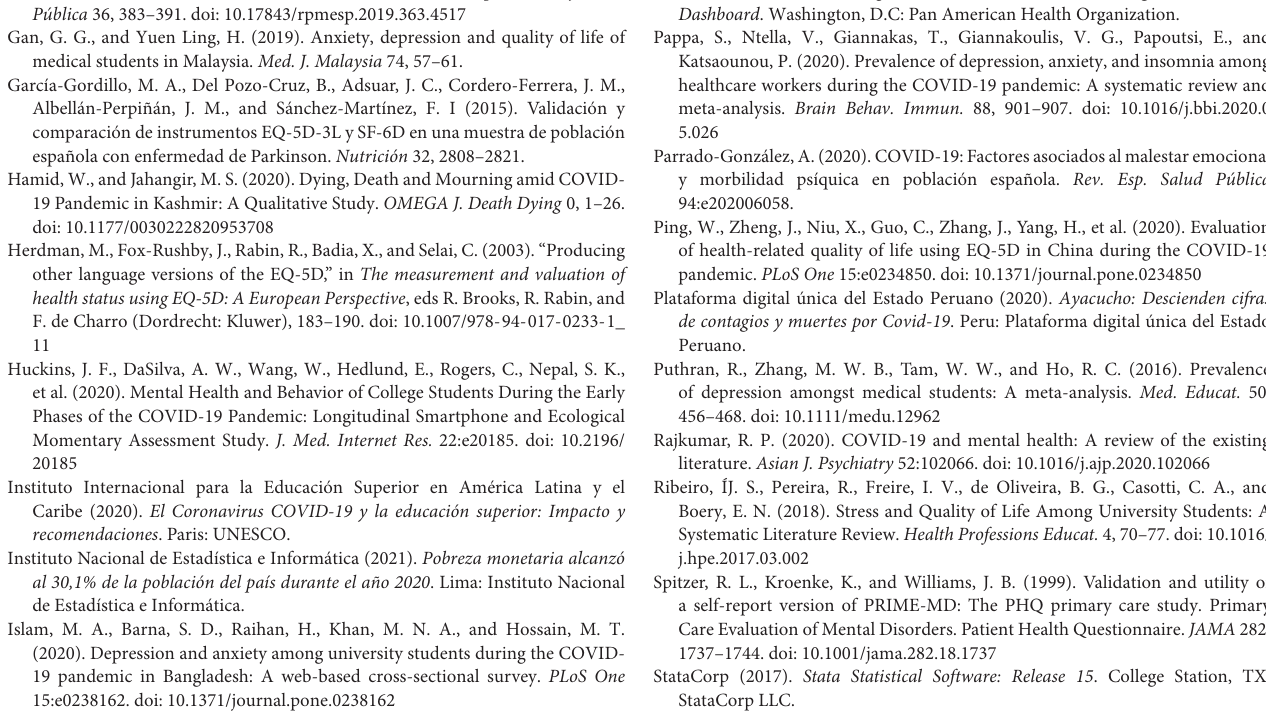
Figallo, F., González, M. T., and Diestra, V. (2020). Perú: Educación superior en el contexto de la pandemia por el COVID-19. Revista de Educación Superior en América Latina 2020:13404. Figueroa-Quiñones, J., and Ipanaqué-Neyra, J. (2020). Pánico por COVID-19 y colapsodelossistemassanitarios. RevistaCubanadeInvestigacionesBiomédicas 39:1064. Figueroa-Quiñones, J., Cjuno, J., Ipanaqué-Neyra, J., Ipanaqué-Zapata, M., and Taype-Rondan, A. (2019). Calidad de vida de migrantes venezolanos en